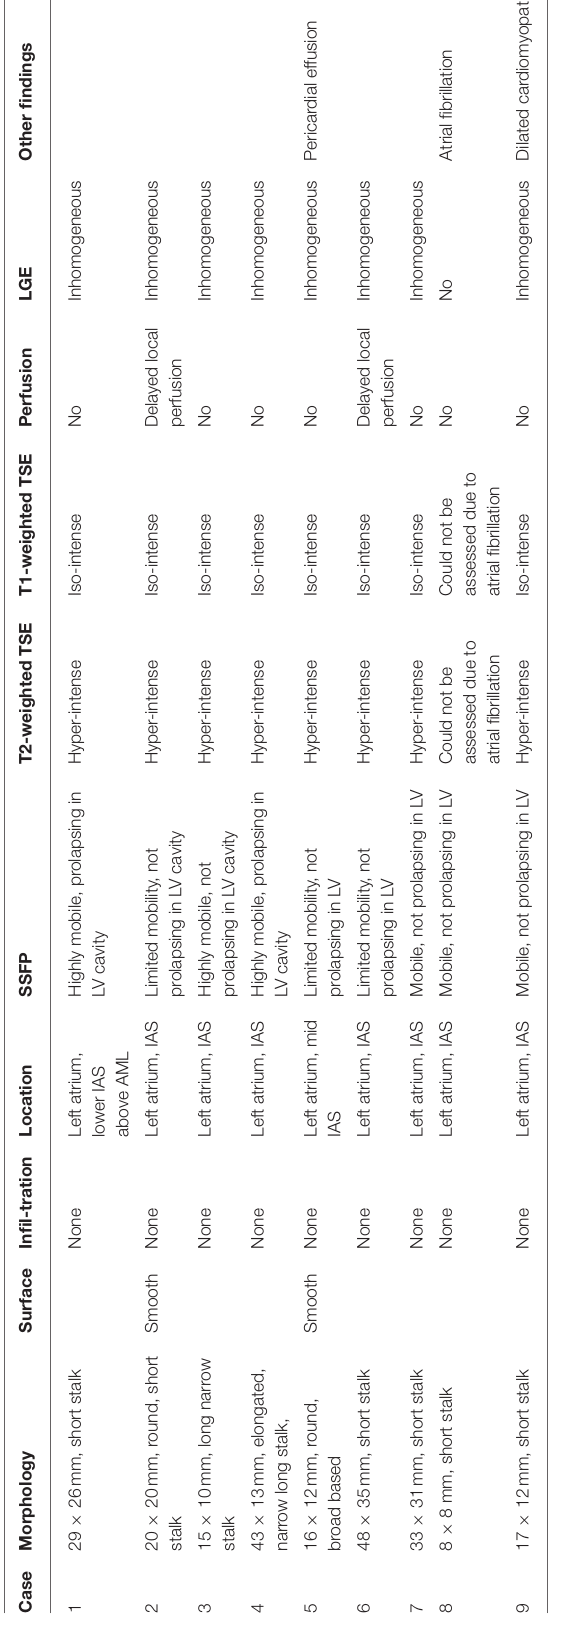
CMR-characteristics of the myxomas are given in Table 2 . Cine images confirmed echocardiographic morphological